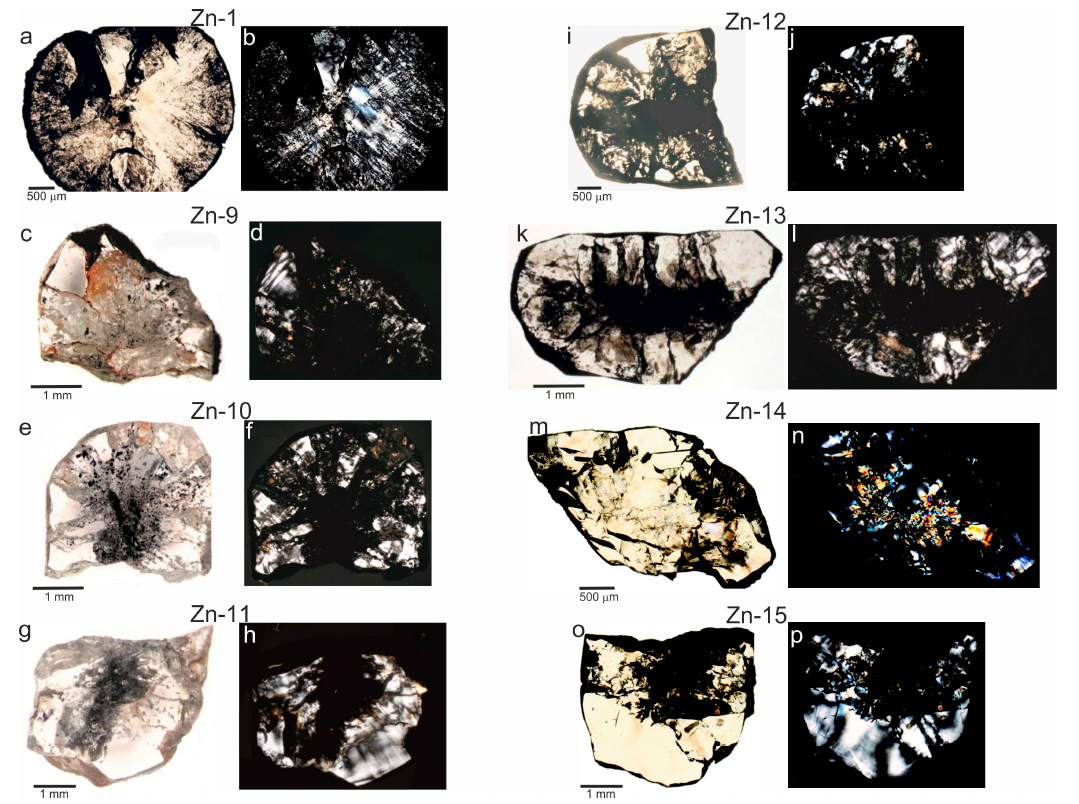
Figure 3. Internal morphology of double-polished diamond plates (( a , c , e , g , i , k , m , o )—transmitted polarized light; ( b , d , f , h , j , l , n , p )—birefringence pattern).